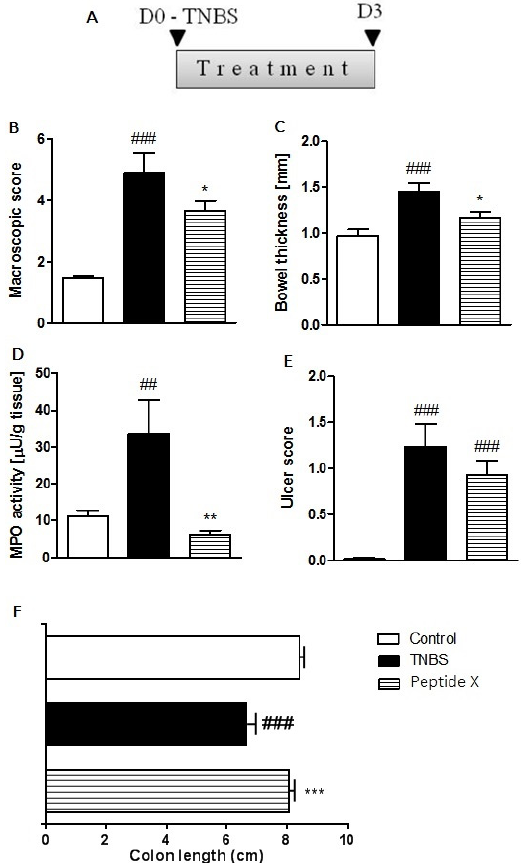
Figure 2. Peptide X injected i.p., twice daily over 3 days at the dose of 1 mg / kg attenuated TNBS-induced colitis in mice. ( A ) A scheme illustrating the protocol and treatment regimen used in this experiment. Figure shows data for the macroscopic score ( B ), bowel thickness ( C ), MPO activity ( D ), ulcer score ( E ) and colon length ( F ). * p < 0.05 and ** p < 0.01, *** p < 0.001 as compared with TNBS-treated